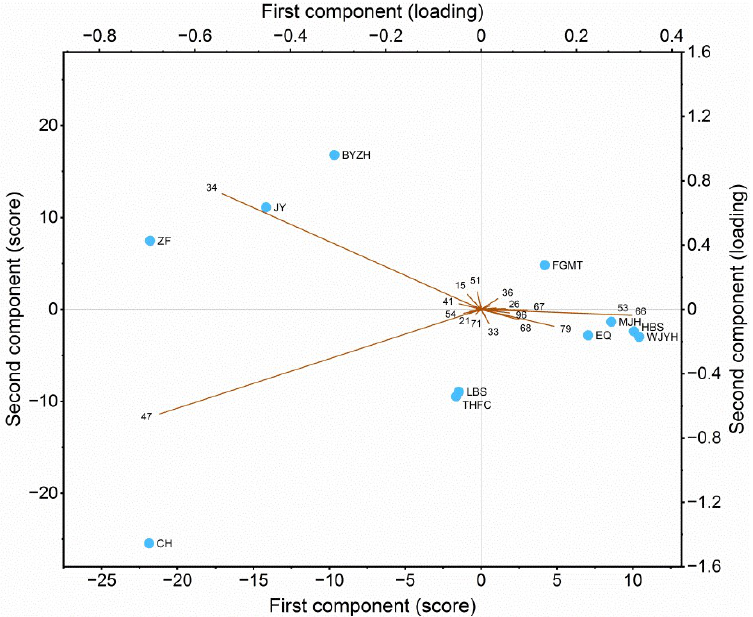
Figure 5. Score and loading plots from PCA of flower essential oils of the eleven woody peony cultivars ( Paeonia × suffruticosa Andr.). Plots are presented along the first two principal components (74.1% of total variance). For codes of cultivar names, see Table 1.